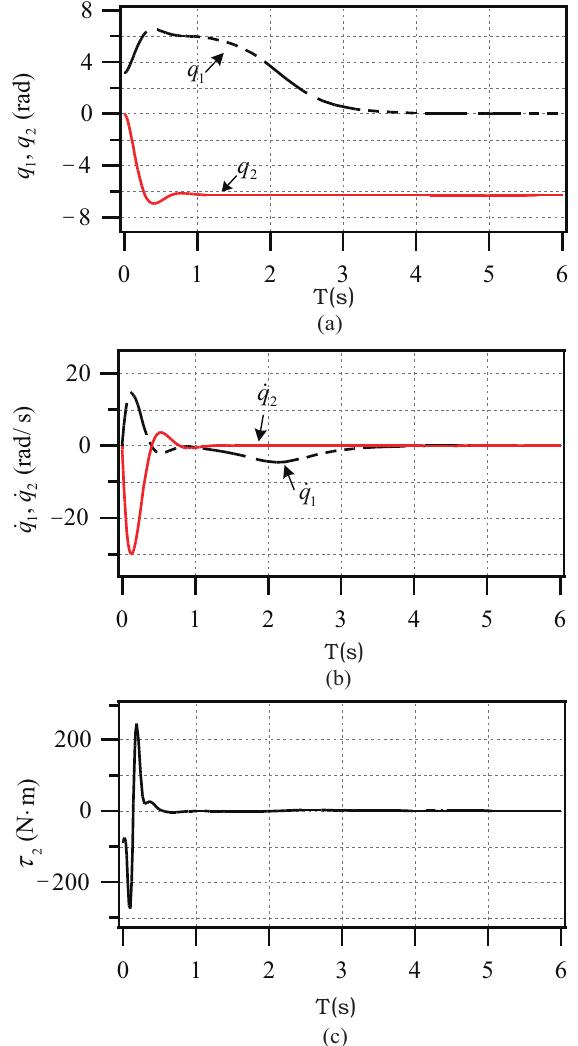
Figure 5. Simulation results with (26): ( a ) angle; ( b ) angular velocity; ( c ) torque.